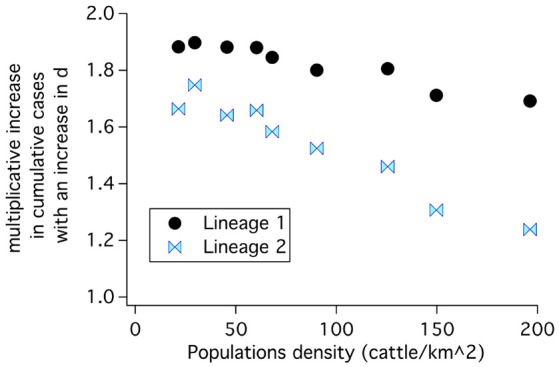
The characteristic distance of spread, d, was increased from 1.3 to 2 km. The cumulative cases at 30 weeks increased for both sets of disease parameters for uncontrolled epidemic propagation.